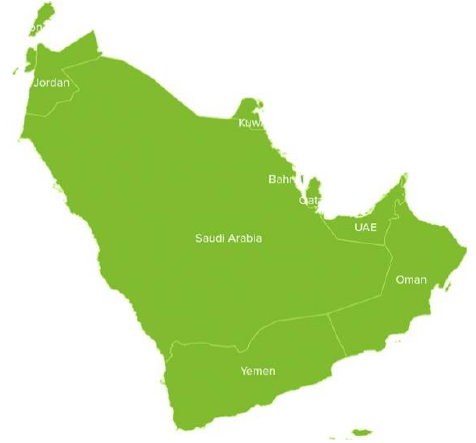
Figure 1. Map of the Arabian Peninsula illustrating the UAE in relation to neighbouring countries. Used with permission from Pngegg.com accessed on 1 June 2021.